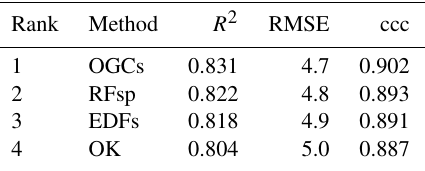
Table 5. Ranked accuracies on the Swiss rainfall dataset for each method. Pairwise t test showed statistically significant ( p < 0 . 05) differences between the methods for all three metrics. The ranks are the same for all three metrics. EDFs – Euclidean distance fields; RFsp – distances to observations; OGCs – oblique geographic co- ordinates; and OK – ordinary